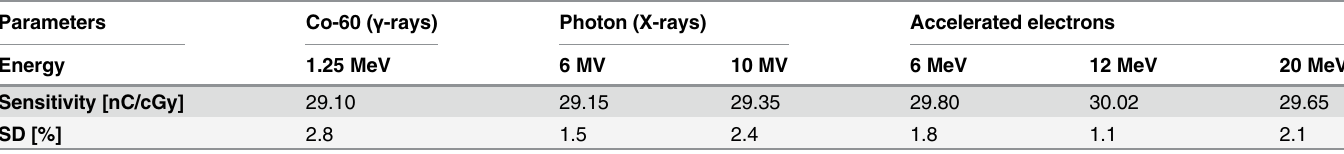
Table 6. Dependency on energy for